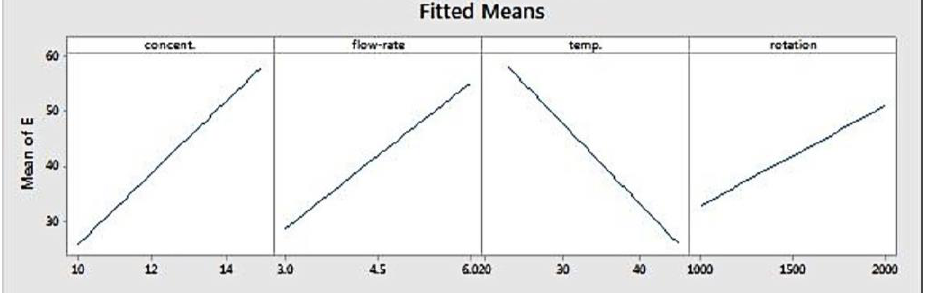
Figure 3. Main effects plot for modulus elasticity.